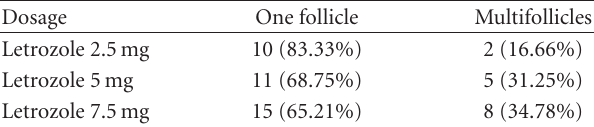
Table 2: Number of follicles in step-up protocol.